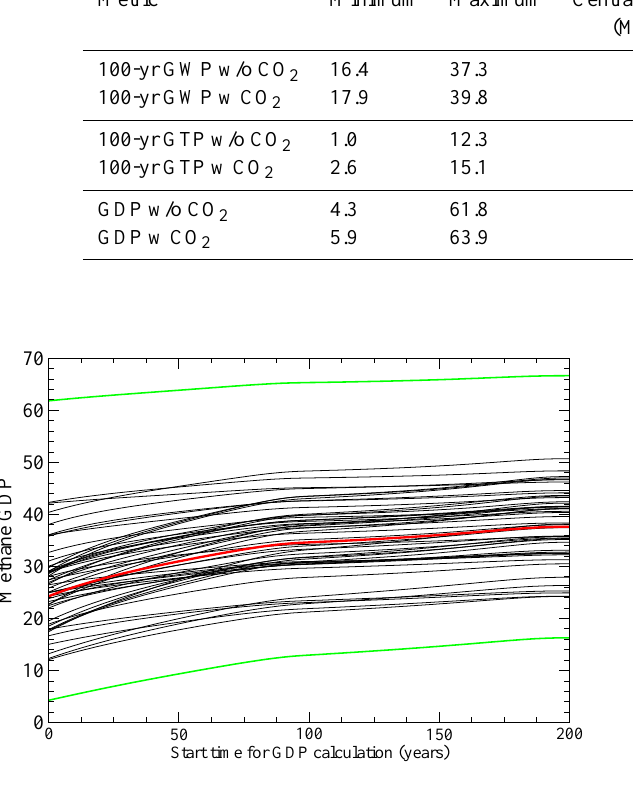
Fig. 3. Methane GDP as a function of the start time for the first 50 members of our Monte-Carlo simulations when randomly perturbing the input parameters with the PDFs specified in Table 1. The red line is for our best guess estimate and the green lines are for the minimum and maximum values for input parameters, as specified in Table 1. The figure shows the case without the CH 4 conversion to CO 2 .